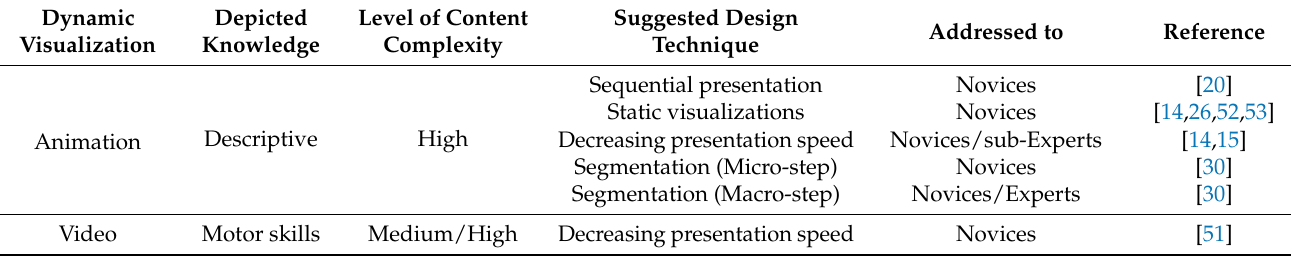
Table 3. Suggested instructional designs to improve learning of tactical scenes of play through dynamic visualizations. Dynamic